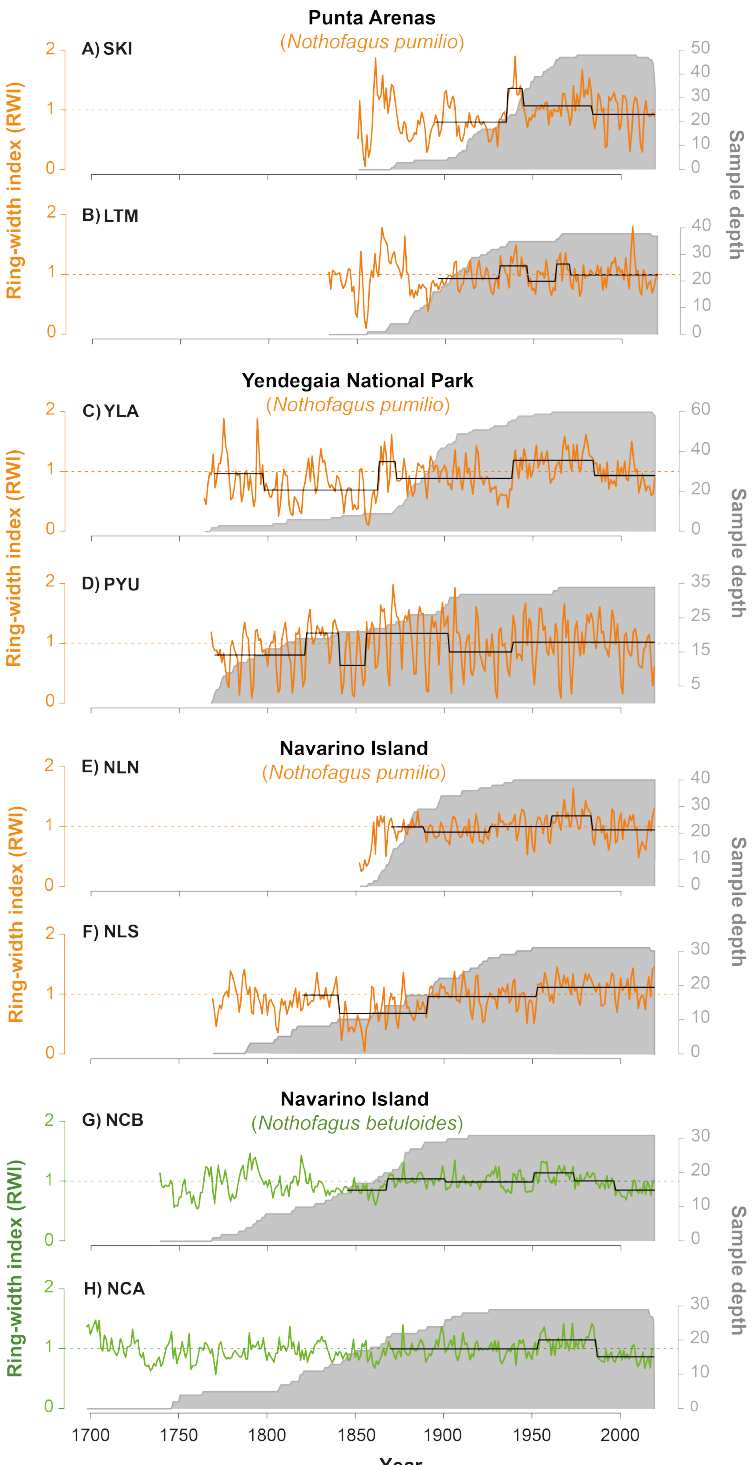
Figure 2. Individual ring-width index (RWI) N. pumilio (orange) and N. betuloides (green) chronologies are displayed as continuous lines. Horizontal dotted lines indicate mean RWI value, grey shading lines the sample depth, and continuous black lines the regime shifts using the detection method [47]. This regimen shift analysis was calculated for the period with chronology EPS values exceeding the threshold of 0.85 (EPS calculated in a moving window of 50 years with an overlap of 25 years